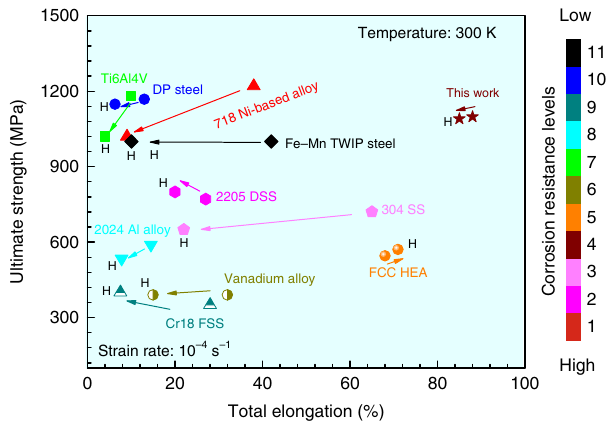
Fig. 5 A summary of total elongation vs. ultimate strength for various alloys with/without hydrogen. The diagram compiles our current results on the equiatomic CoNiV MEA, TWIP steel 50 , high-strength dual- phase steel (DP) 51 , austenitic stainless steel (SS), ferritic stainless steel (FSS) 52,53 , duplex stainless steel (DSS) 54,55 , nickel-based alloy 30,56 , vanadium alloy 57 , aluminum alloy 58 , titanium alloy 59 , and Cantor alloy (f.c.c. HEA) 31 . All samples were probed at the same slow strain rate level (10 − 4 s − 1 ) and at the same temperature of 300 K. The combination of high resistance to hydrogen embrittlement and corrosion together with its maintained mechanical properties observed in the equiatomic CoNiV MEA exceeds that of many other alloys. The corrosion resistance levels shown here have been calculated using the corrosion current density in 0.1 M H 2 SO 4 solution, changing from high (1) to low (11) as expressed by the color legend. The arrows in this Ashby diagram show in which direction the mechanical properties change when the alloys are exposed to hydrogen.